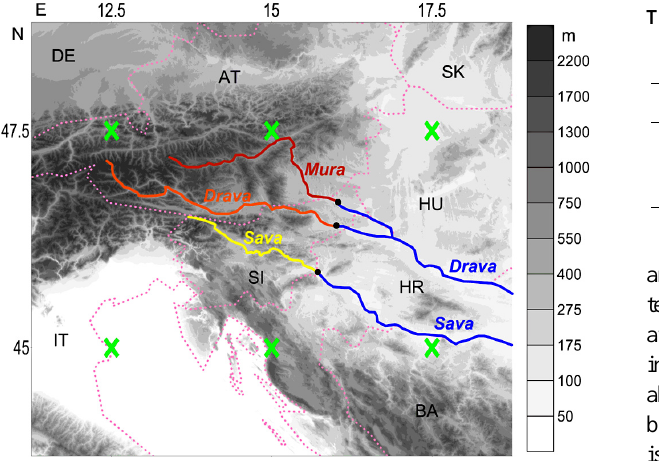
Table 1. Studied